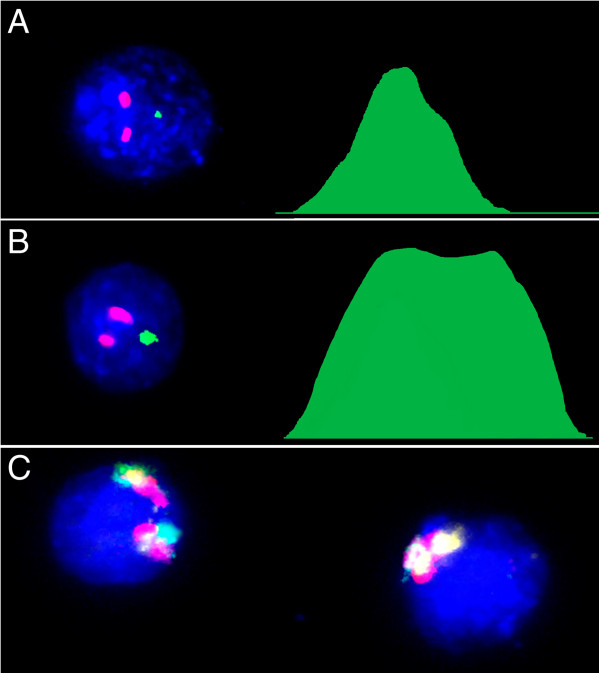
Molecular neurocytogenetic analyses of the AD brain. (A) multiprobe (two-probe) and quantitative FISH using DNA probes for chromosomes 1 (two red signals/D1Z1) and X (one green signal DXZ1/relative intensity is 2120 pixels) demonstrating true X chromosome monosomy; (B) multiprobe (two-probe) and quantitative FISH using DNA probes for chromosomes 1 (two red signals/D1Z1) and X (one green signal DXZ1/relative intensity is 4800 pixels) demonstrating overlapping of two X chromosome signals, but not a chromosome loss; (C) ICS-MCB with a probe set for chromosome X showing one nucleus bearing two chromosomes X and another nucleus bearing single chromosome X.